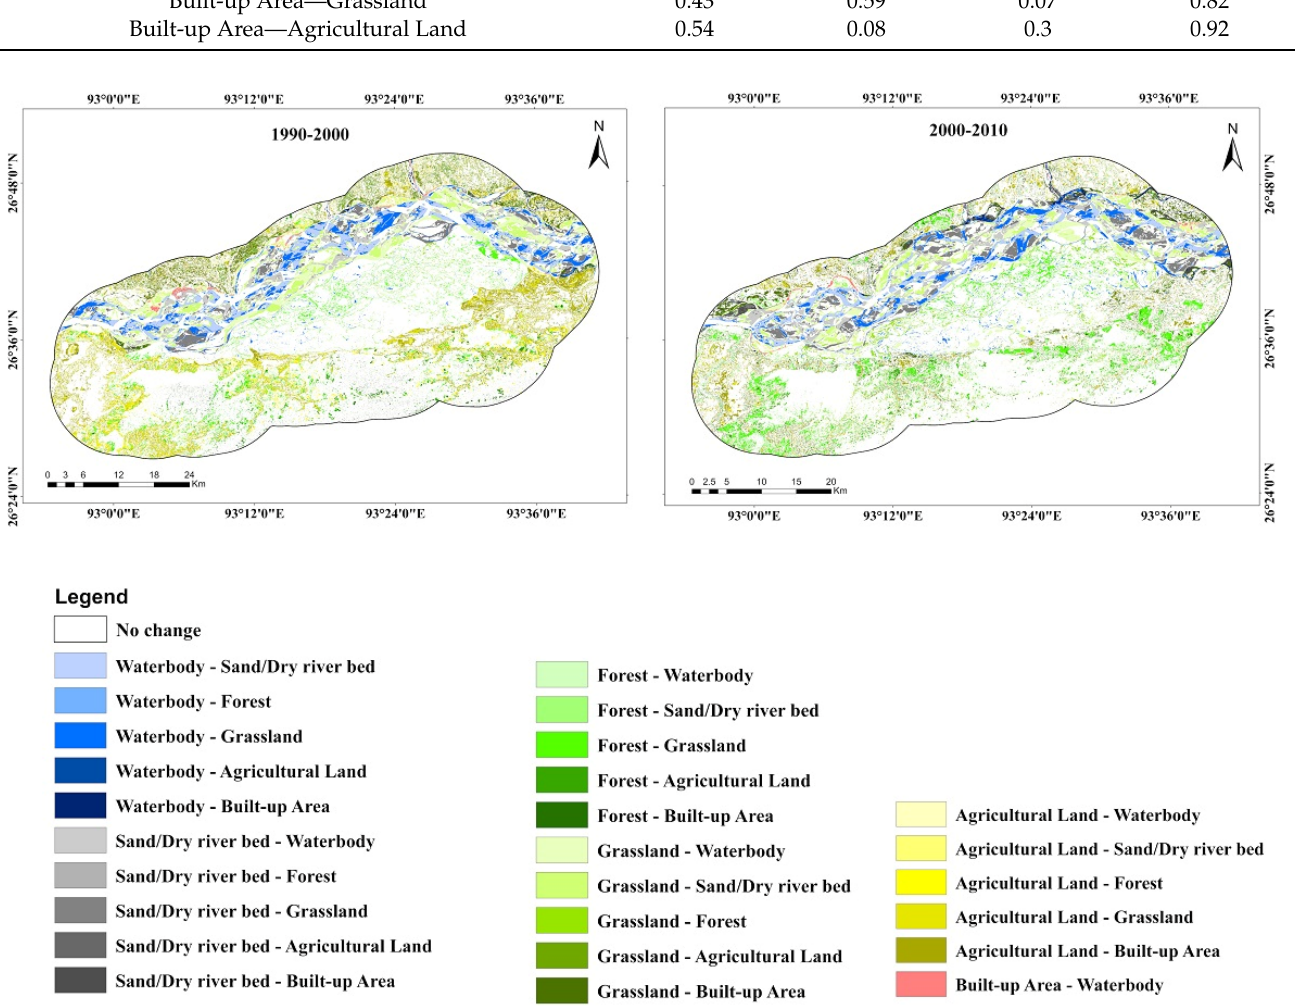
Figure 5. Change map of different LULC classes between 1990–2000 and 2000–2010.